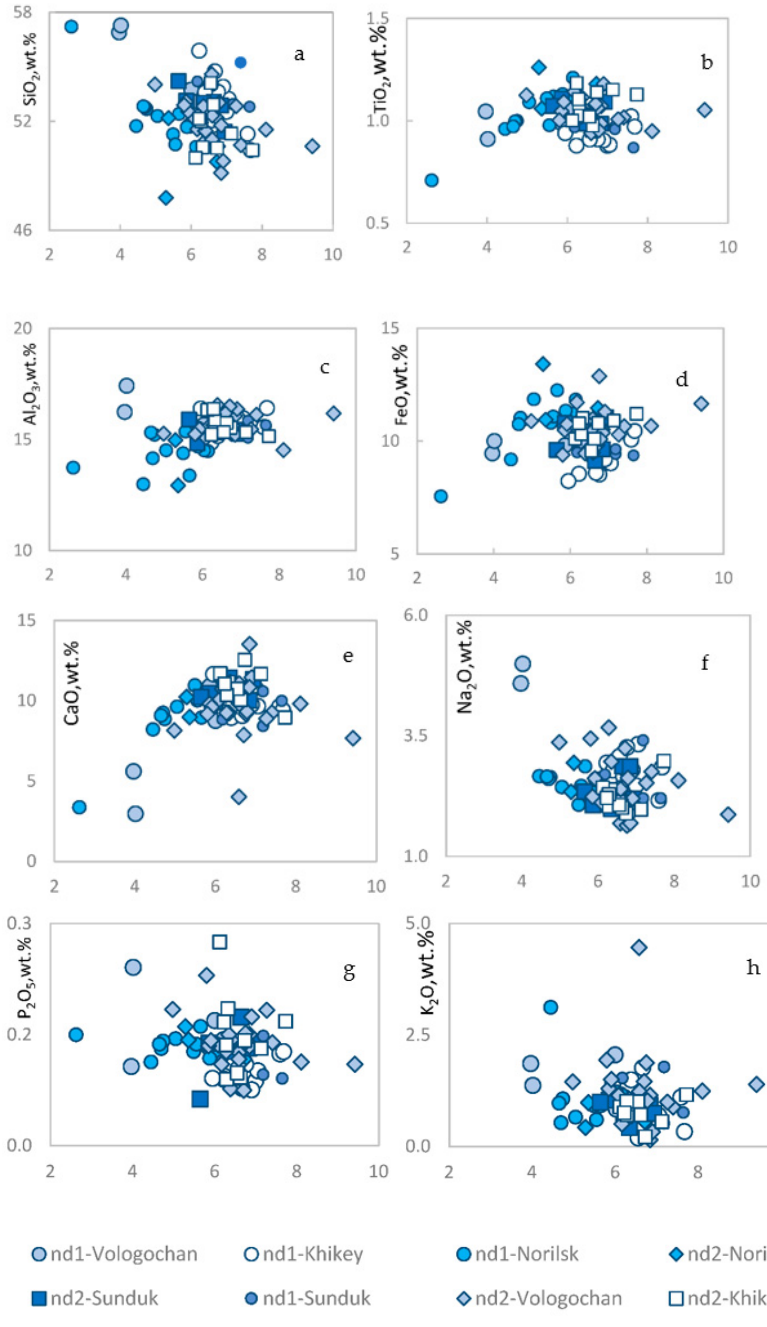
Figure 13. Diagrams MgO vs. SiO 2 ( a ), TiO 2 ( b ), Al 2 O 3 ( c ), FeO ( d ), CaO ( e ), Na 2 O ( f ), P 2 O 5 ( g ), and K 2 O ( h ) for the rocks of the Nadezhdinsky Formation.